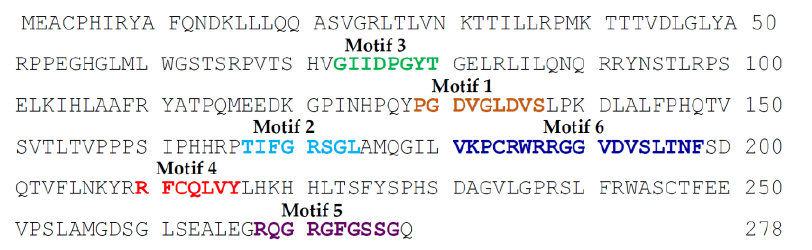
Figure 1. Epstein-Barr Virus deoxyuridine triphosphate nucleotidohydrolase (EBV-dUTPase) amino acid sequence. Typical dUTPase motifs 1–5 and the unique motif 6 characteristic of the Herpesviruses dUTPase family are depicted.